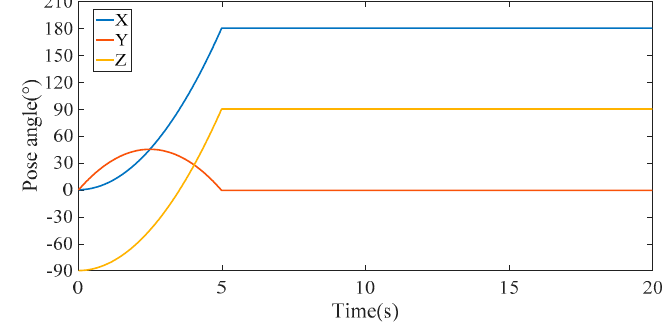
Figure 19. Schematic diagram of the processed 3D point cloud.